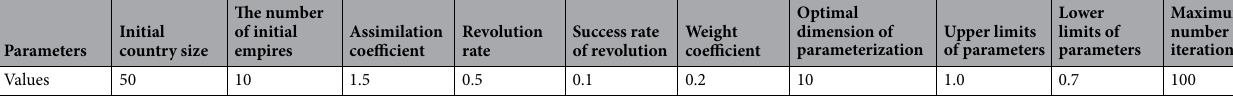
Table 5. Relevant parameters of ICA.